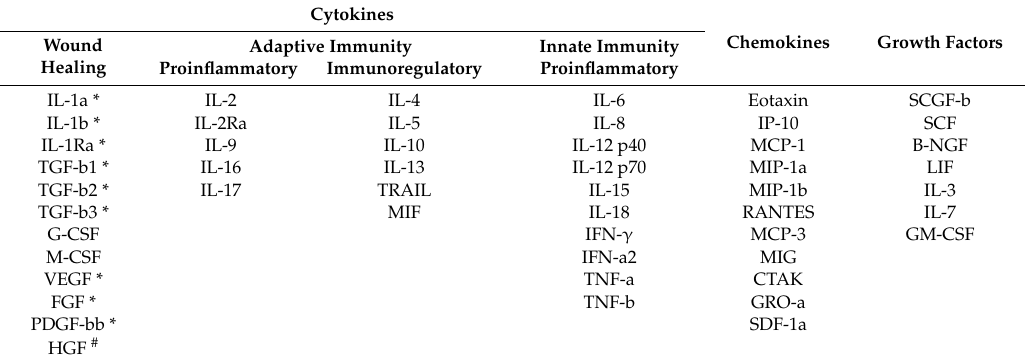
Table 2. Analyzed tear soluble